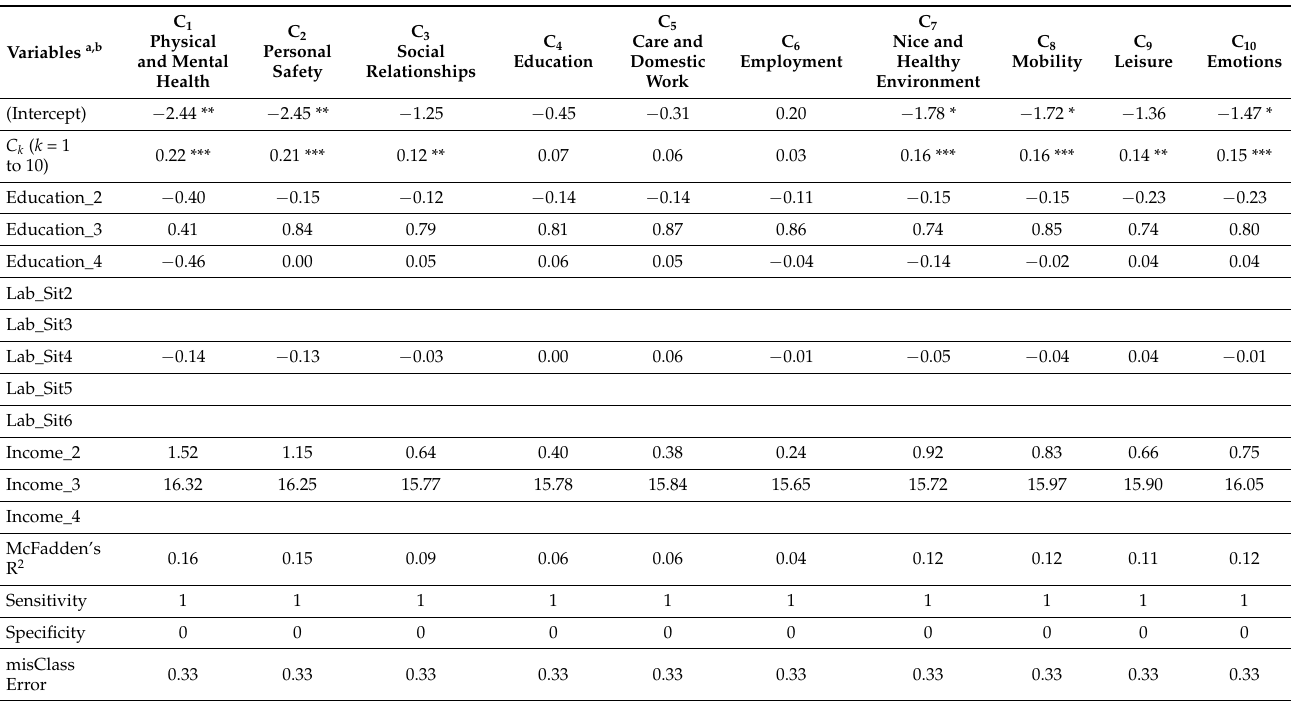
Table A5. Significance of coefficients of regressions with different capabilities. Women and age 65 and